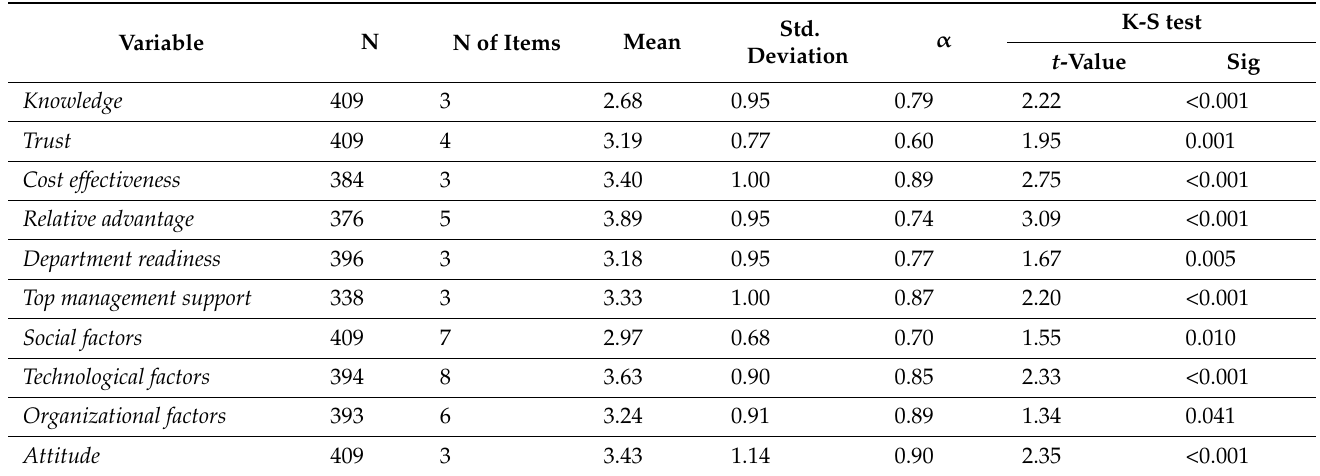
Table 3. Descriptive statistics for variables.